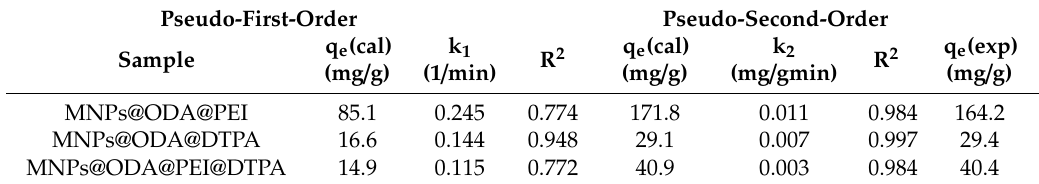
Table 1. Parameters for the pseudo-first-order and pseudo-second-order models.